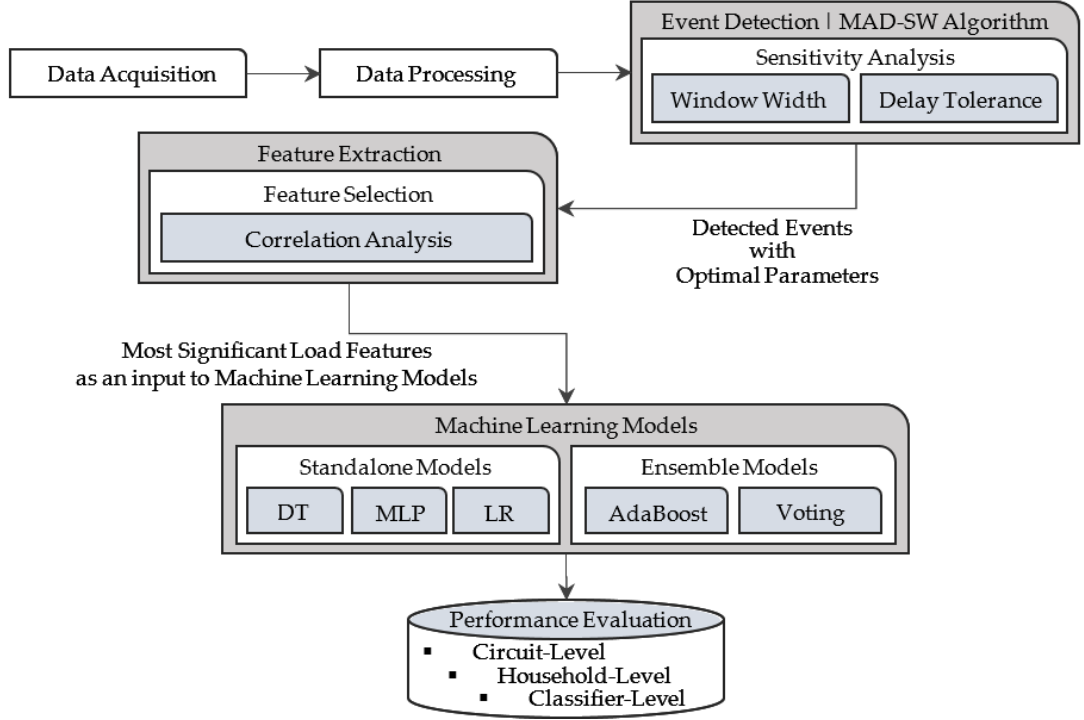
Figure 1. Research methodology.